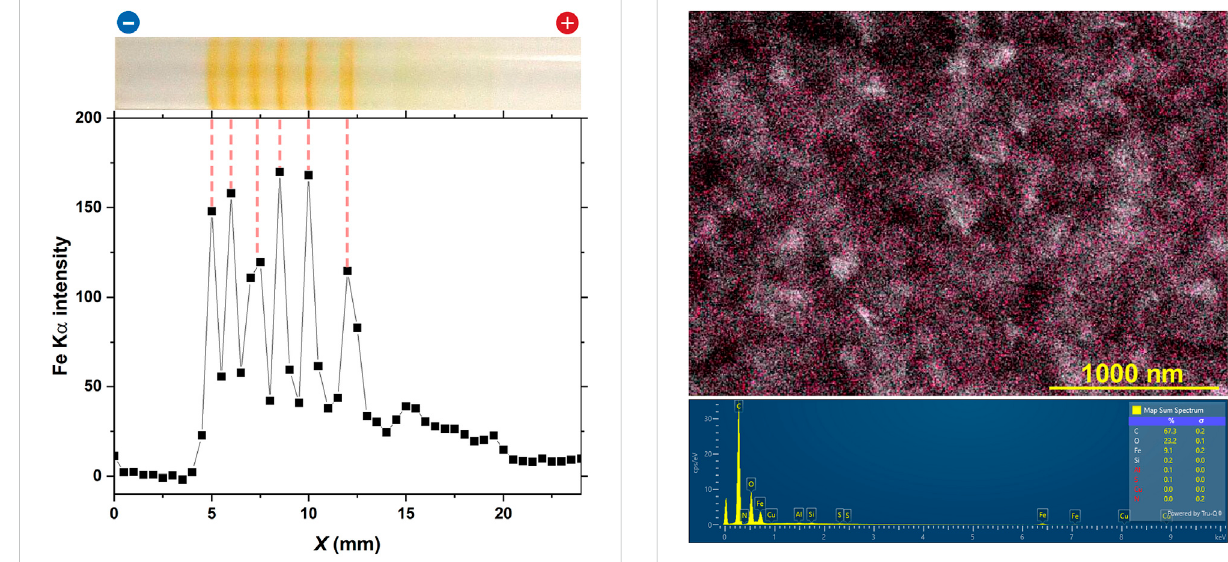
FIGURE 9 Fe K α intensity distribution of the periodic bands formed in the gel column of L = 50 mm at 25 ° C under the following applied cyclic alternatingvoltages: E H =3 V, E L =1 V, T H =1h, T L =4h,and N C =8.An image of the gel column is displayed at the top to facilitate comparison with the periodic bands. The charges of the electrodes, which have been used for preparation, are provided at the top of the image. The vertical dashed lines serve as guides.